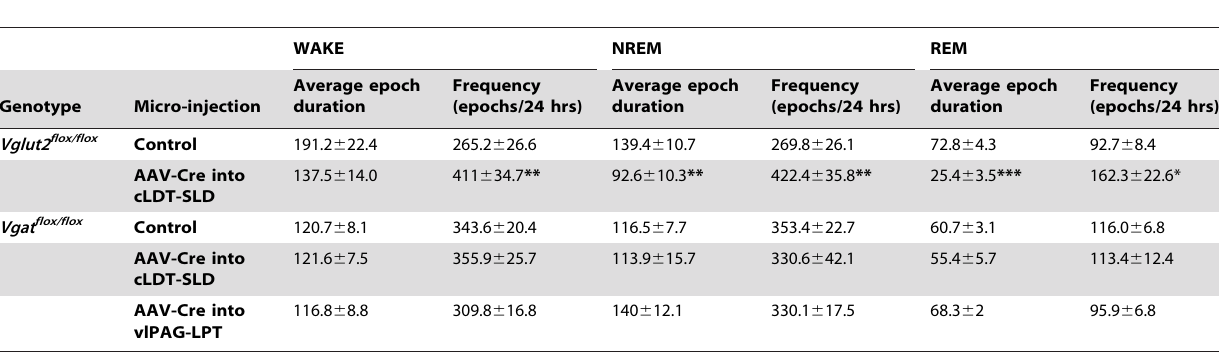
Table 1. The effects of VGLUT2 and VGAT knockout on average bout duration (sec) and frequency of wake, NREM sleep and REM sleep across 24 hrs.